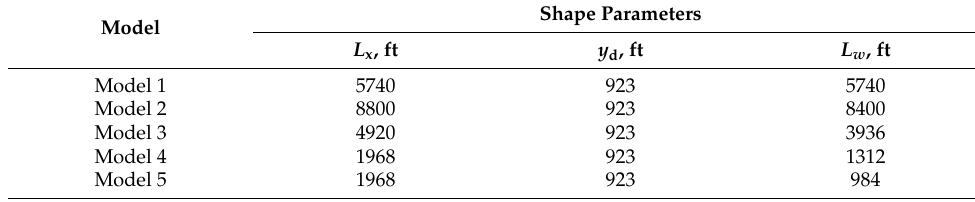
Figure 4. The schematic of a horizontal well located in the drainage area. Note that the relative position of the horizontal well in the drainage area is different in each model. Table 2. Reservoir properties for the horizontal well in simulation examples.